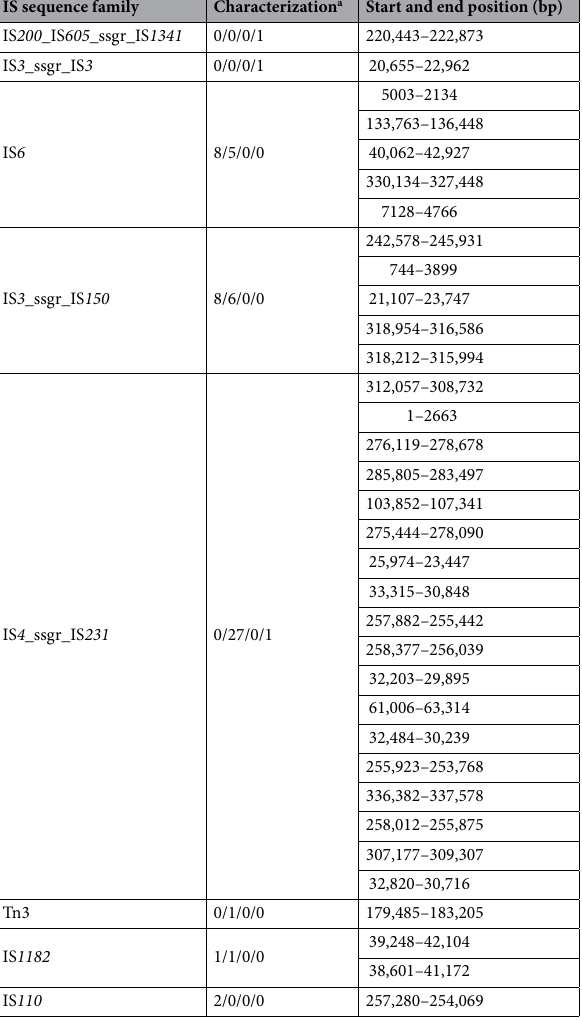
Table 5. The varieties and quantities of IS sequences in plasmid pHS18-2. a Complete sequence/partial sequence/pseudogenes/unknown